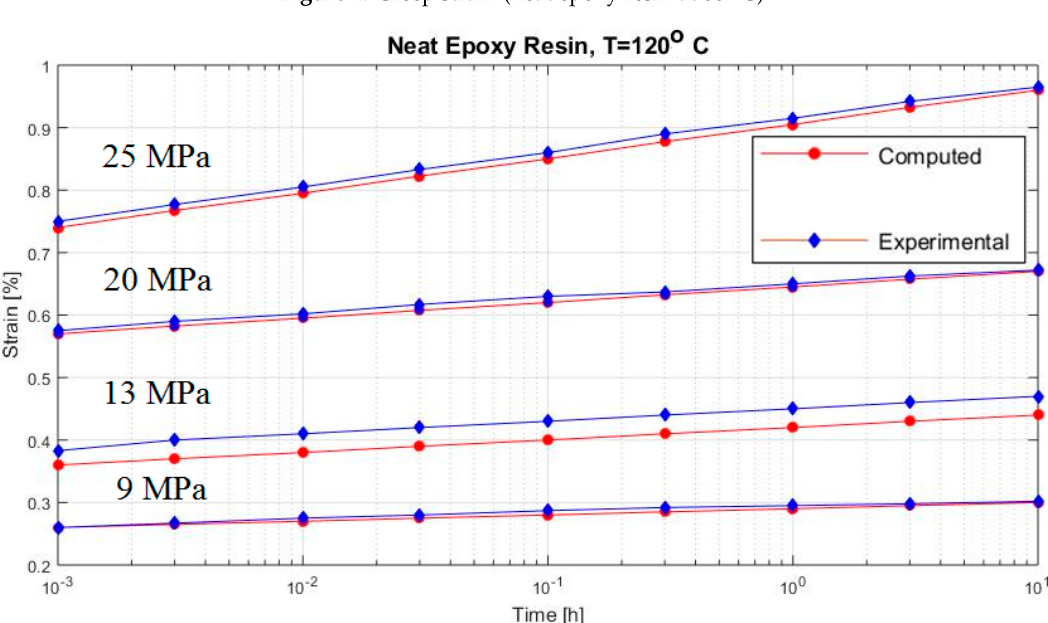
Figure 4. Creep strain (neat epoxy resin at 80 °C).